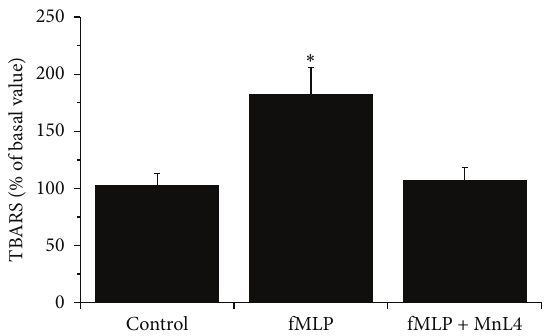
Figure 6: Effect of 10 −7 M MnL4 on the lipid peroxidation (TBARS) induced by superoxide anion in human chondrocytes. Human chondrocytes were coincubated with RAW 264.7 with or without 10 −7 M MnL4. RAW 264.7 were activated by 10 −7 M fMLP for 4h to produce superoxide anions. Values are expressed as percentage of controlvalues(humanchondrocytescoincubatedwithunstimulated RAW 264.7). TBARS in control value was 1.65 ± 0.18 𝜇 moles mg −1 of total proteins. Each value represents the mean of 5 experiments, performed using chondrocytes isolated from 3 patients. ∗ 𝑃 < 0.05 versus all other